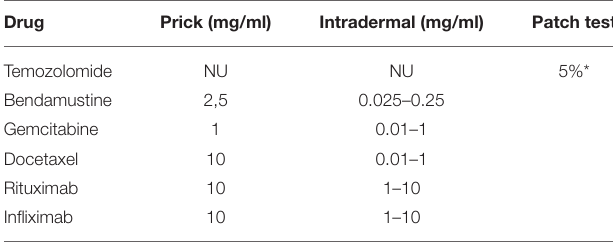
TABLE 2 | Drug concentration for skin